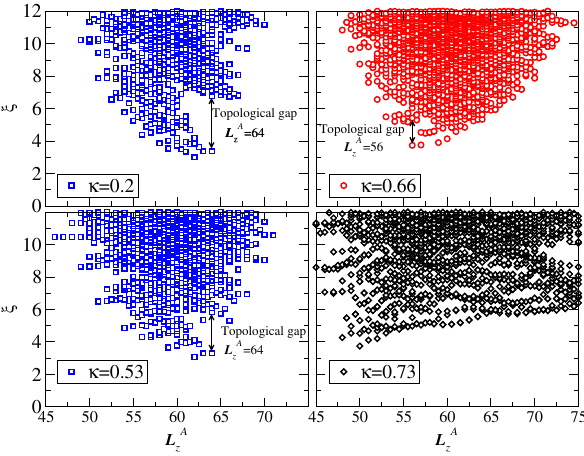
FIG. 7. Entanglement spectrum for N Φ ¼ 29 at κ ¼ 0 . 2 , 0.53, 0.66, and 0.73. The entanglement spectra at κ ¼ 0 . 2 and 0.53 are shown in blue to emphasize their consistency with a ground state in the universality class of the MR Pfaffian. At κ ¼ 0 . 66 , we show the entanglement spectra between the two entangle- ment entropy peaks in the lower panel of Fig. 13. It is colored red to indicate that its low-lying level structure has some similarity to states in the aPf universality class, although the entanglement gap is too small to allow for any definitive statements. At κ ¼ 0 . 73 , the entanglement spectrum completely changes to that of the unknown phase to the right of the second entanglement entropy peak in Fig. 13. We also indicate the definition of the “ topological gap ” for κ ¼ 0 . 2 , 0.53, and 0.66 as described in the text.